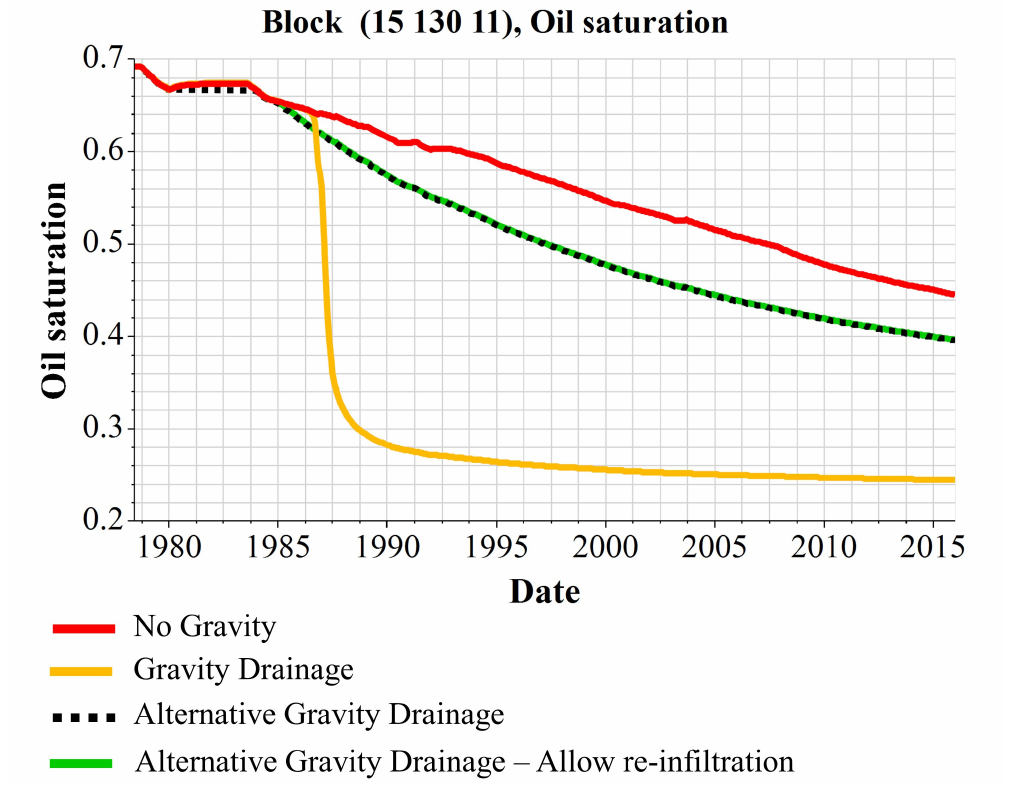
Figure 19. Comparison of the oil saturation profile using different formulas of gravity drainage in the matrix block (15 130 11). Where the gravity drainage model (Gilman and Kazemi model)